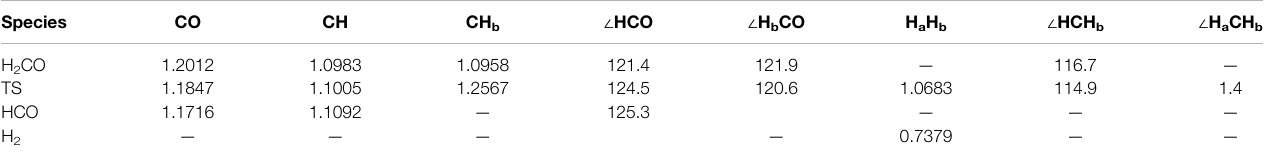
TABLE 2 | Molecular geometry parameters of the fragments [bond lengths (Å) and angles ( ° )] at the M05-2X/aug-cc-pVTZ level. H b is the abstracted atom, while H a is the incoming atom.